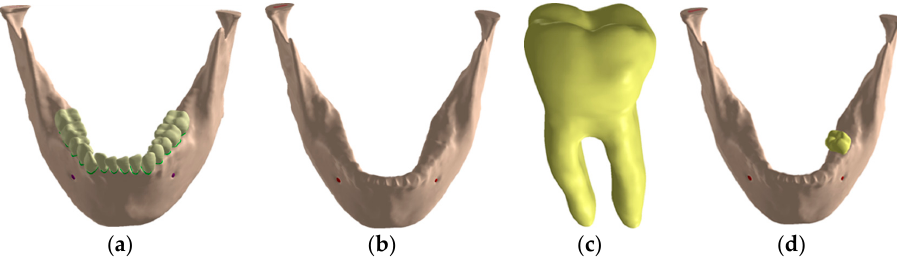
Figure 3. Jaw three-dimensional model: ( a ) Jaw with teeth; ( b ) edentulous jaw; ( c ) model of the extracted tooth; ( d ) tooth insertion in the edentulous mandible.